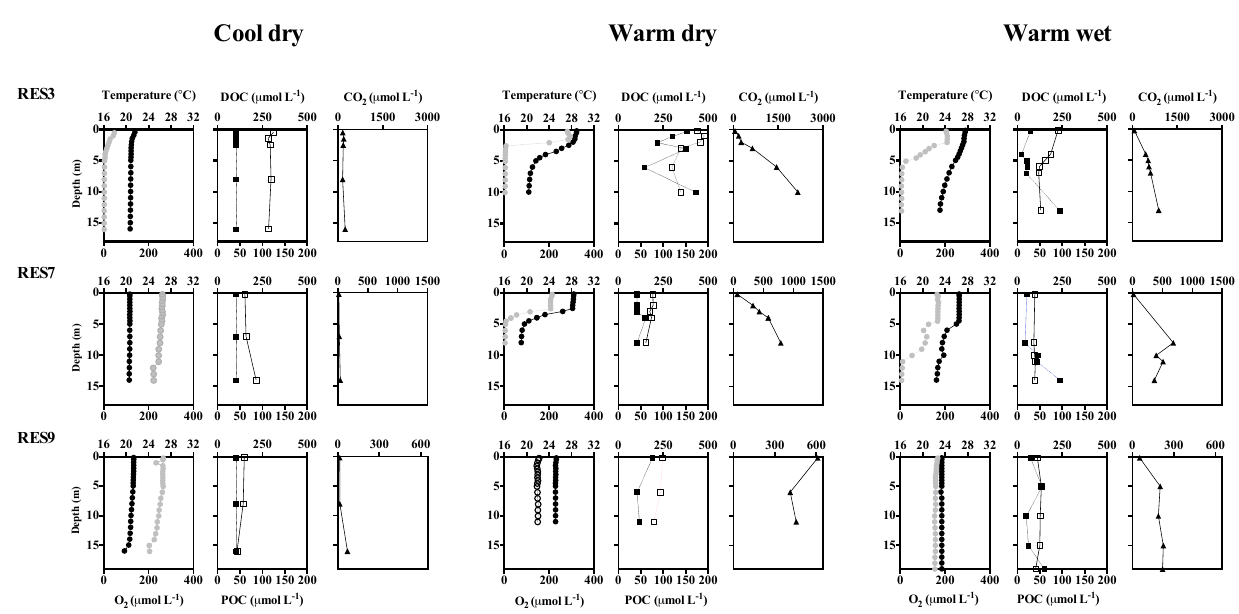
Figure 4. Temperature (grey solid circle) and oxygen (black solid circle), DOC (open square) and POC (solid square), and CO 2 (triangle) concentrations in the Nam Theun 2 Reservoir water column during the cool dry (CD), warm dry (WD) and warm wet (WW) seasons in 2011 at three stations (RES3, RES7 and